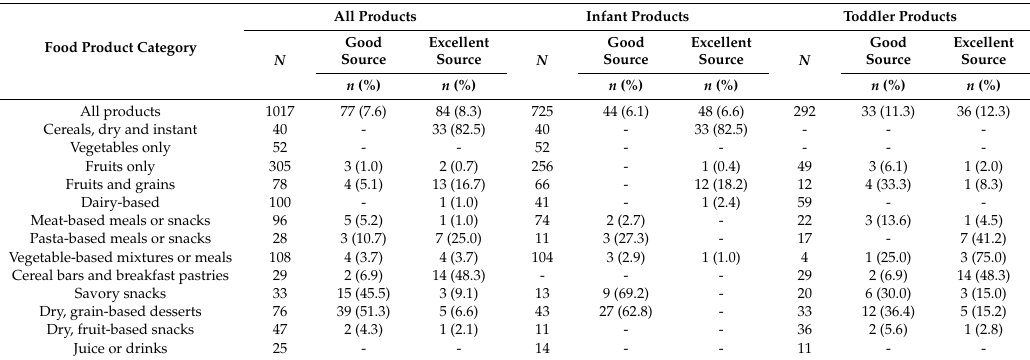
Table 1. Proportion of infant a and toddler a food or drink products considered good b and excellent c sources of iron on the basis of daily value (DV) d by food category, 2015.